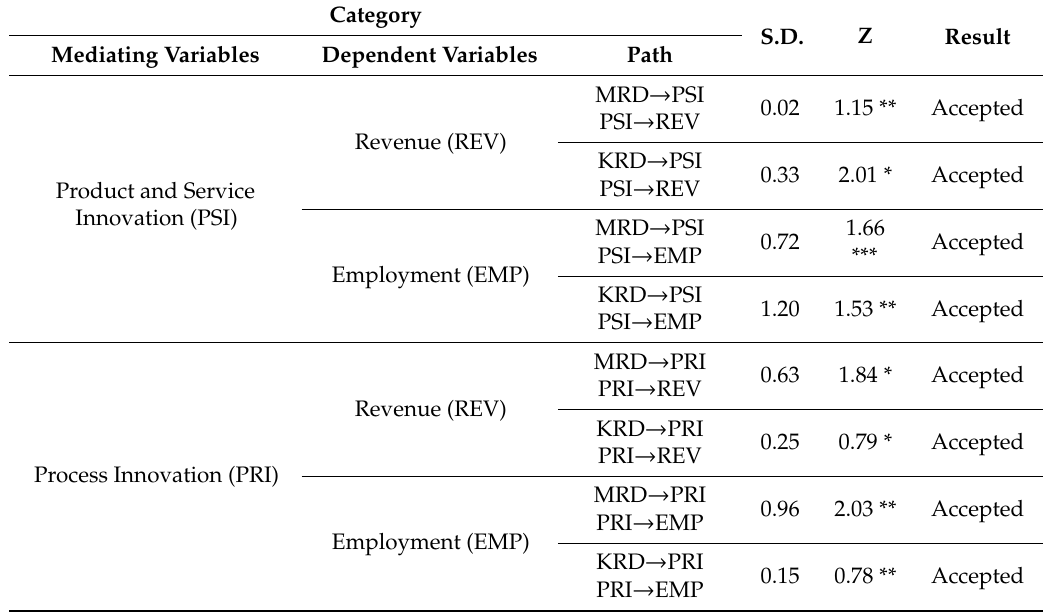
Table 6. Summary of Sobel test